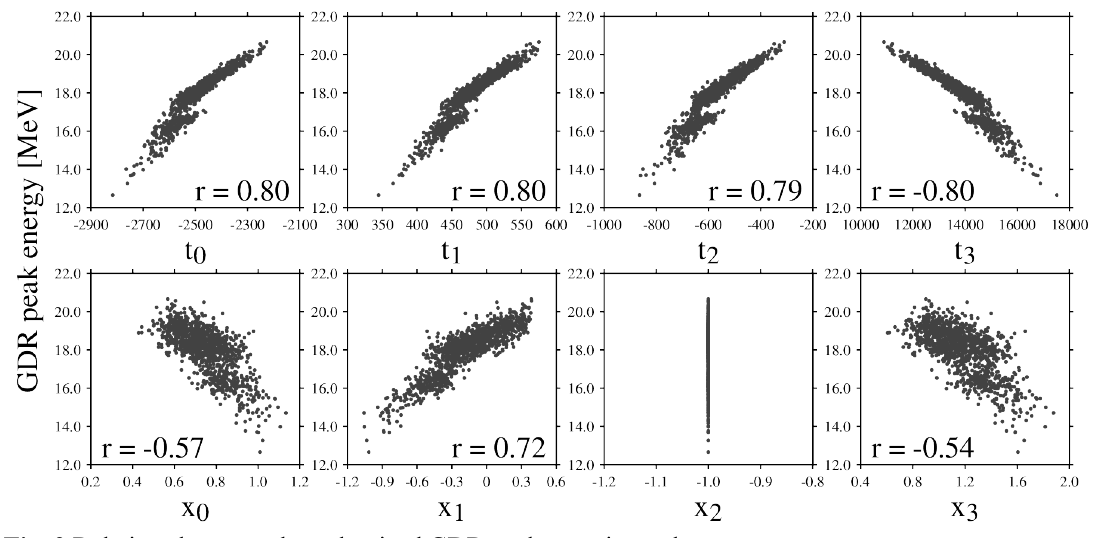
Fig. 2 Relations between the radomized GDR peak energies and paramers, and , and Pearson correlation coefficients. 𝒕𝒕 𝟑𝟑